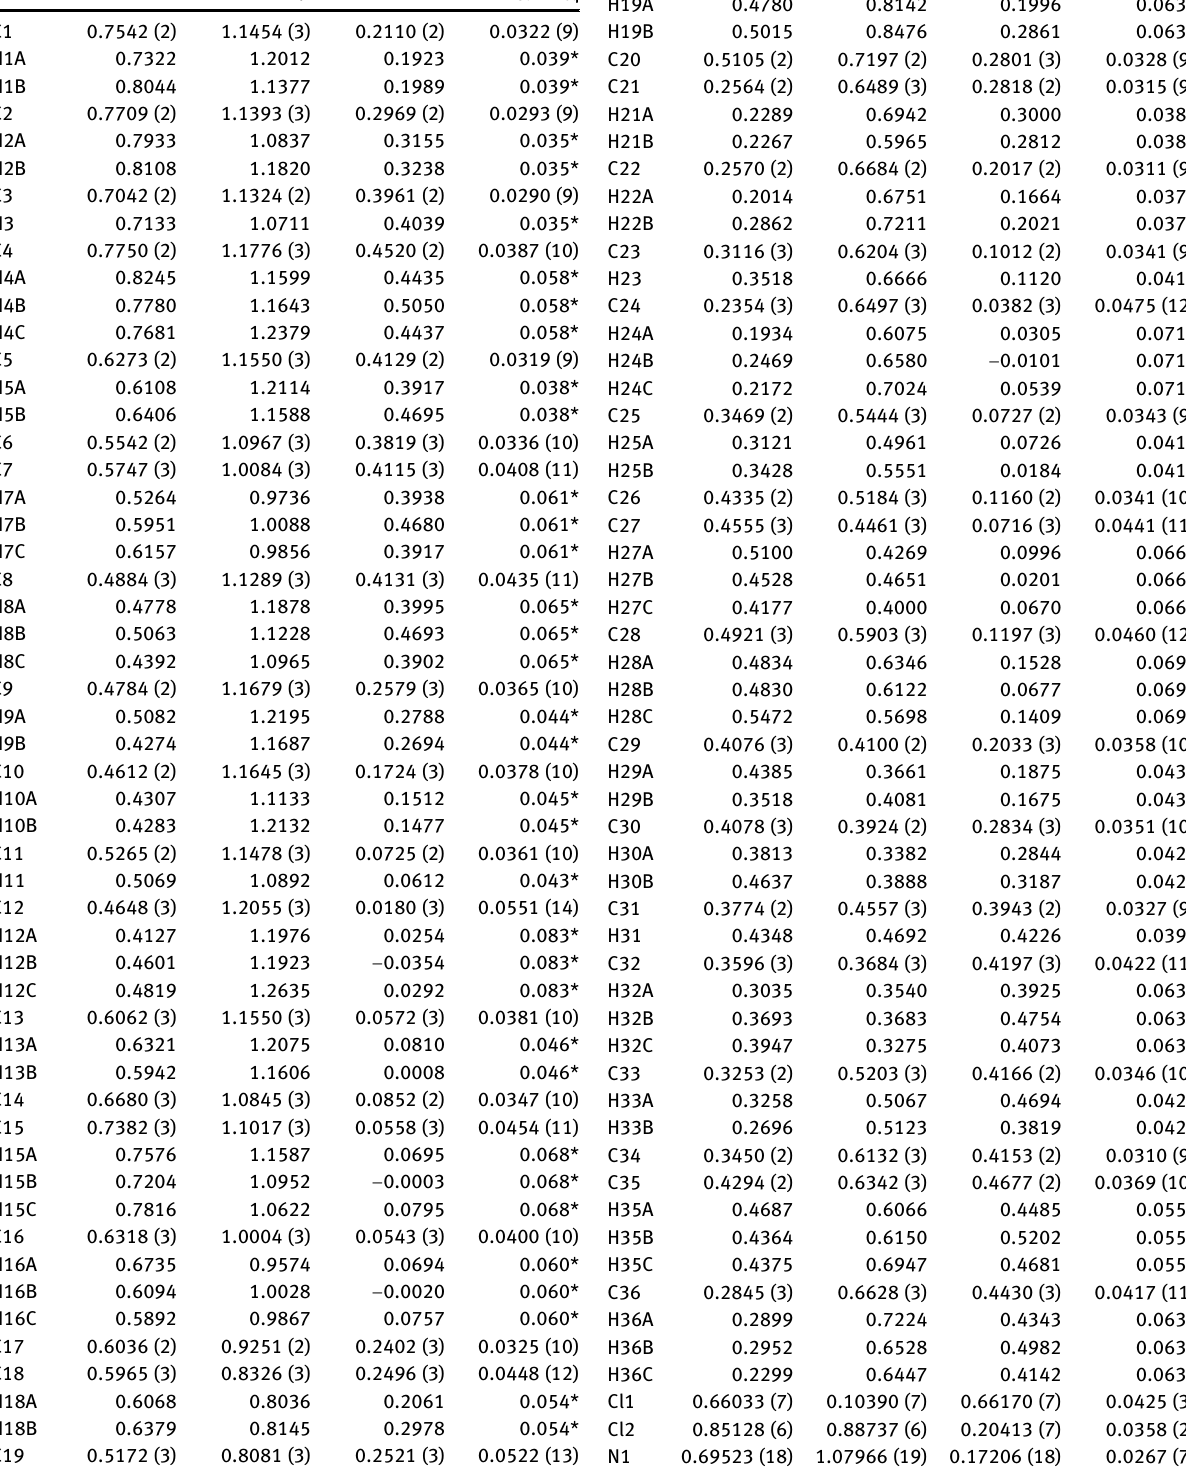
Table  : Fractional atomic coordinates and isotropic or equivalent isotropic displacement parameters (Å 